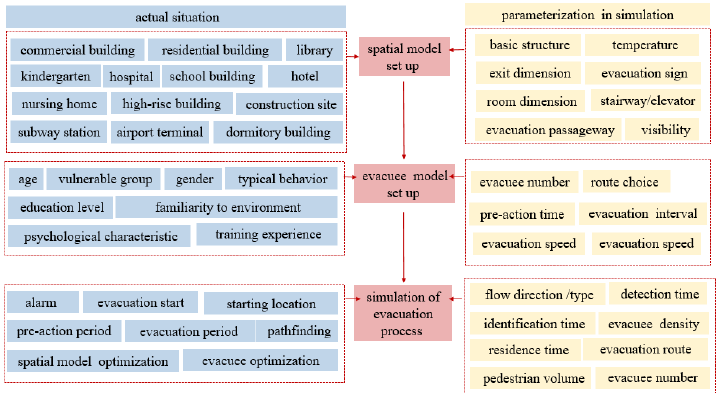
Figure 9. Outline for the implementation of fire safety evacuation simulation.